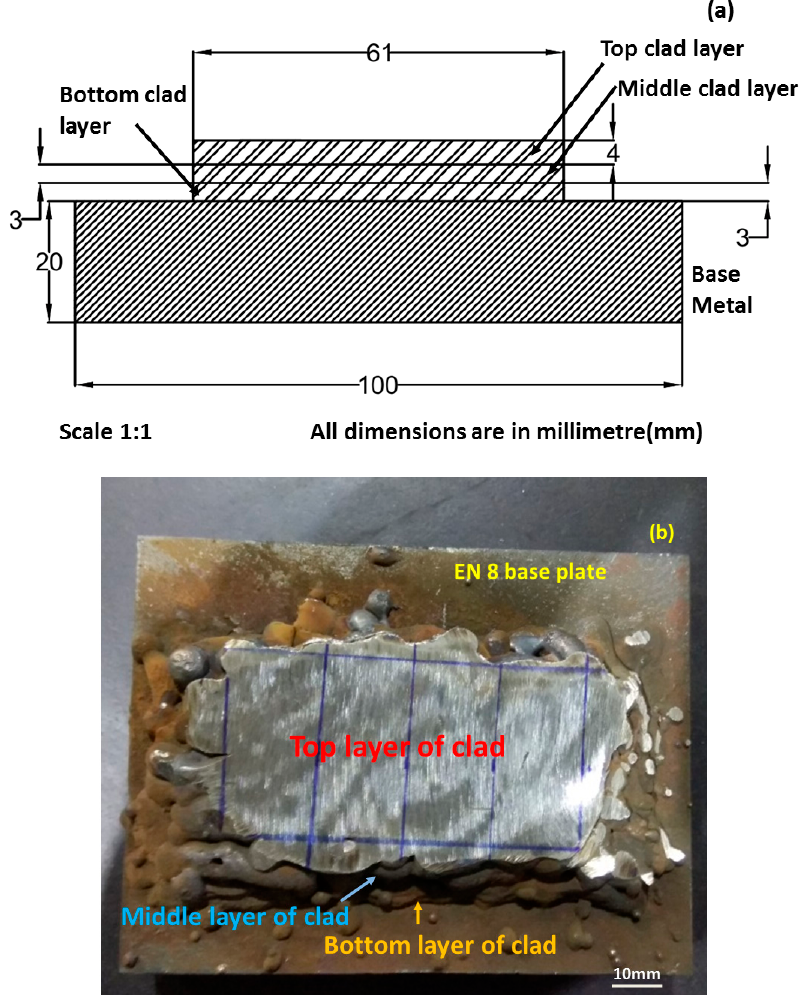
Figure 1. ( a ) Schematic representation of layer thickness. ( b ) Cladding on EN 8